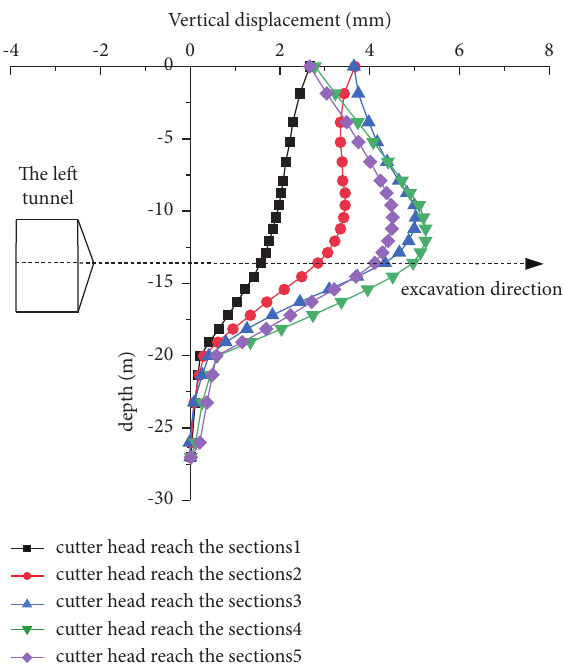
Figure 23: The left tunnel excavation gap